Question: Express in one sentence what the figure is showing.
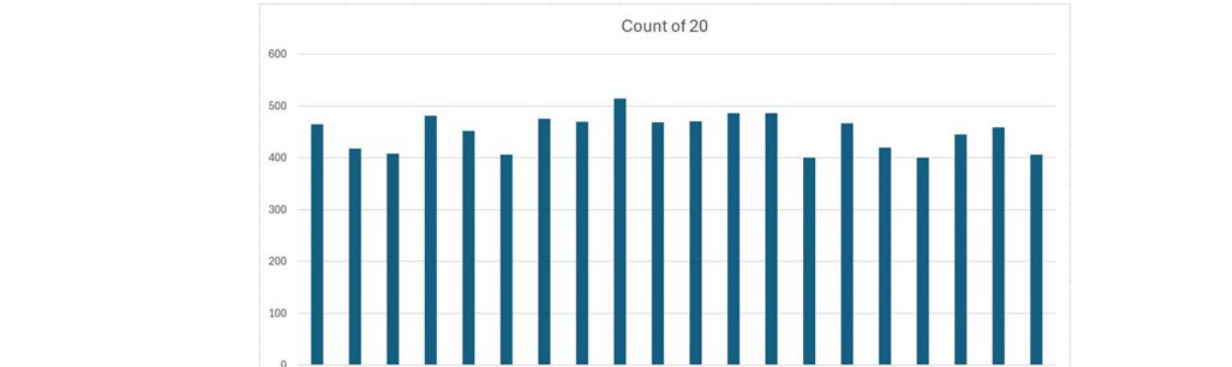
Answer: Statistical distribution for 20-sided dice.